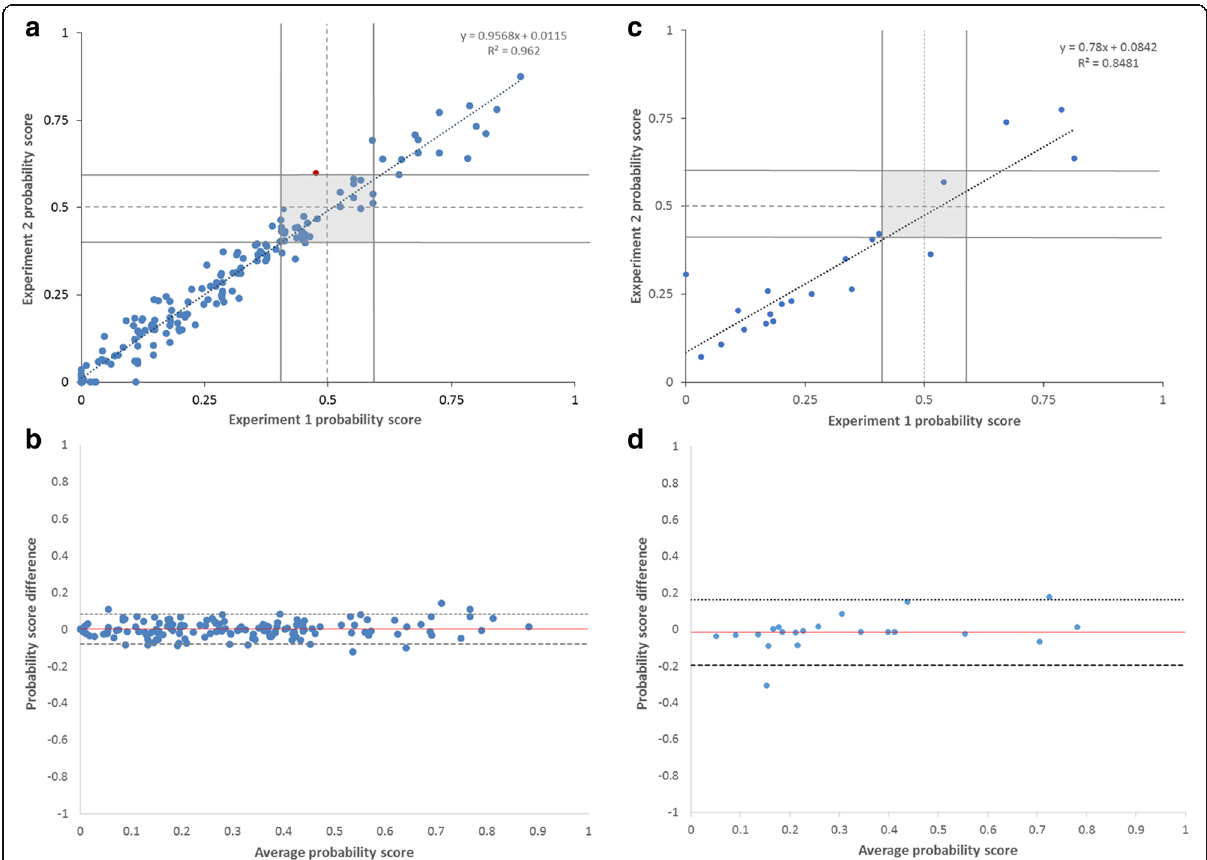
Fig. 4 Results from concordance studies on probability score values of the DecisionDx-Melanoma test. a Inter-assay correlation analysis for 168 cases; b Bland-Altman plot for 168 cases showing estimated bias (mean difference in probability scores, red line) and 95% confidence interval (dashed lines); c instrument-to-instrument correlation analysis for 21 cases; d Bland-Altman plot for 21 cases showing estimated bias (mean differ- ence in probability scores, red line) and 95% confidence interval (dashed